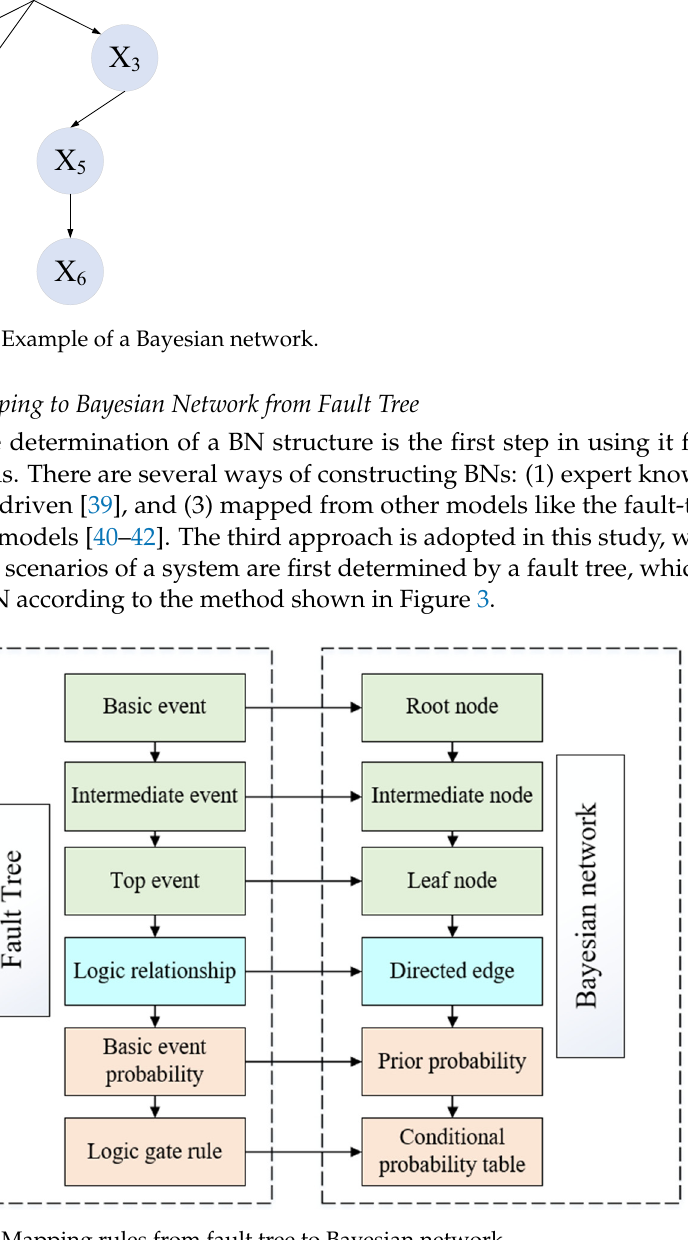
1 Table 2. CPT corresponding to the OR gate in FT (Occ: occurred; Non: non-occurred). X 1